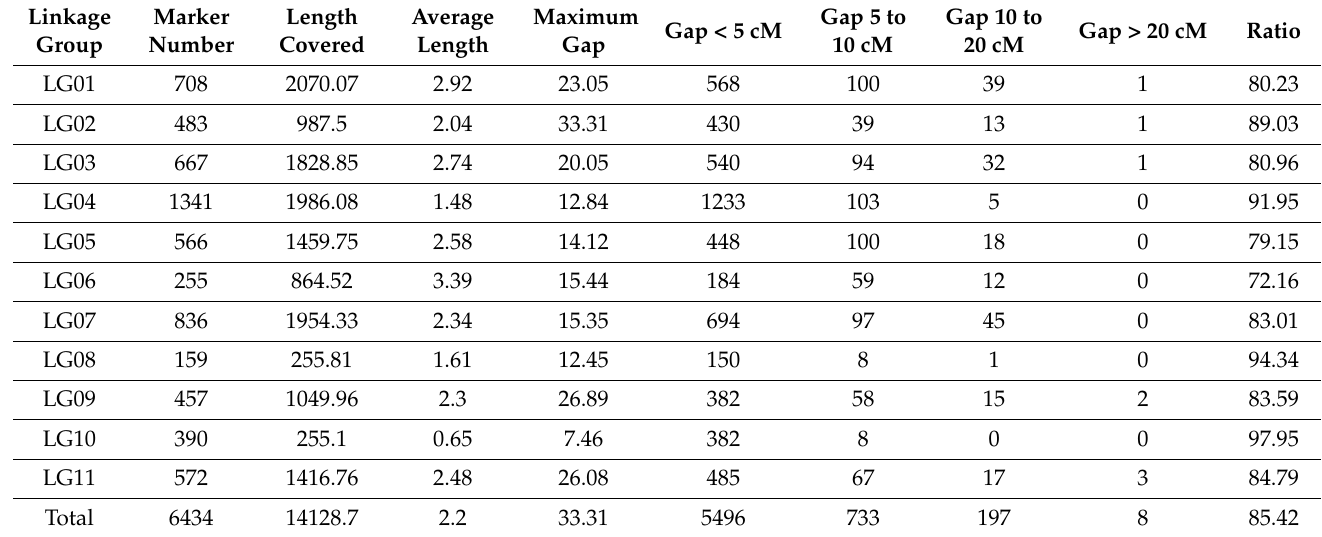
Table 3. Summary of genetic markers and mapping of 11 linkage groups of Hylocereus species.